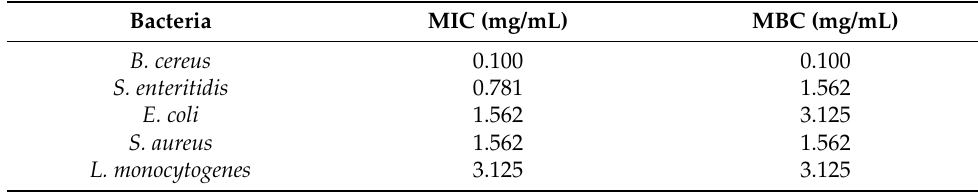
Table 2. MIC and MBC values of Duchesnea indica